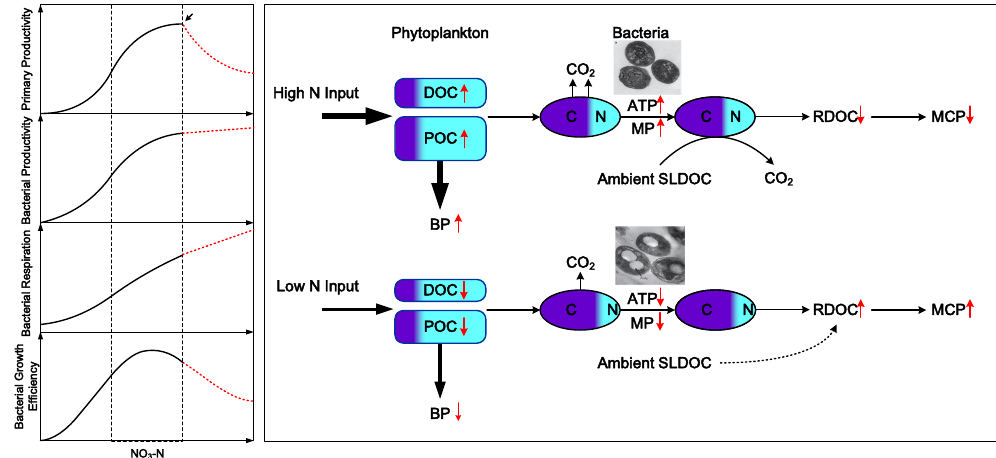
Figure 4. The impact of nutrient supply on the sequestration of carbon via the BP and the MCP. Left panel: primary production, bacterial respiration and bacterial growth efficiency as functions of nutrients. The arrow in the top graph shows a tipping point of nutrient concentration beyond which primary production could drop down due to the constrains of limiting factors other than nutrients, such as light availability and environmental carrying capacity. The red lines after the tipping point emphasize the differences between phytoplankton and bacteria in their response to high nutrients. The appropriate nutrient concentrations for a healthy ecosystem would range between the vertical dashed lines where the ecosystem could remain sustainable while running at a high level of biological efficiency. Right panel: responses of the BP and the MCP to nutrient inputs. (MP – membrane potential; ATP-adenosine triphosphate). With high nutrient input, although the BP could be enhanced, the MCP could be reduced, because microbial respiration can also be stimulated by nutrients. Meanwhile ambient semi-labile DOC could be remobilized for microbial utilization, especially with the priming effects of the labile DOC generated by enhanced primary production. In contrast, if nutrient input is appropriate, the BP could remain moderate, semi-labile DOC could remain persistent, the MCP could be enhanced, and the storage capacity of the combined BP and MCP could be maximized.